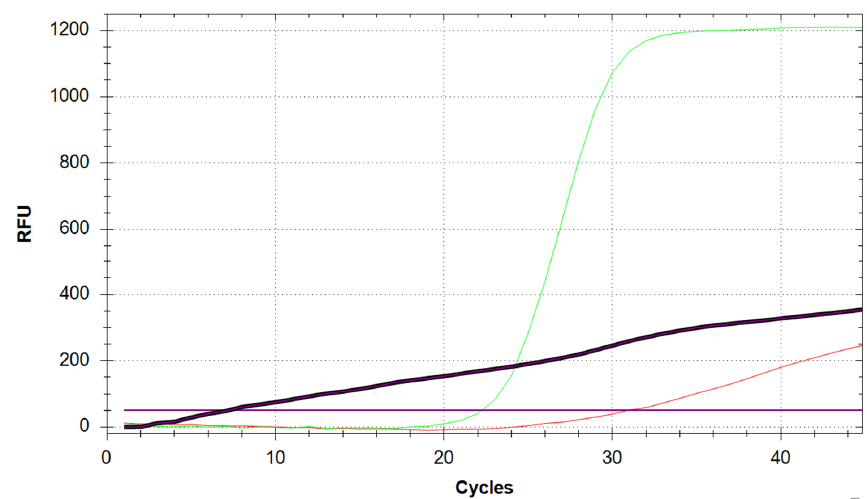
11 of 12 Figure 5. Saliva sample (bold curves) showing sub ‐ optimal amplification of both N (green arrow) and E (blue arrow) genes but successful amplification of RNase P (purple arrow). Correct amplifi ‐ cation of all three targets from the control sample is also shown (thin curves). The horizontal lines represent the RFU threshold for each target. 4.4. Signal Drift Suboptimal amplification and contamination can sometimes be confused with signal drift. However, the latter is an artifact that is usually characterised by an earlier appear ‐